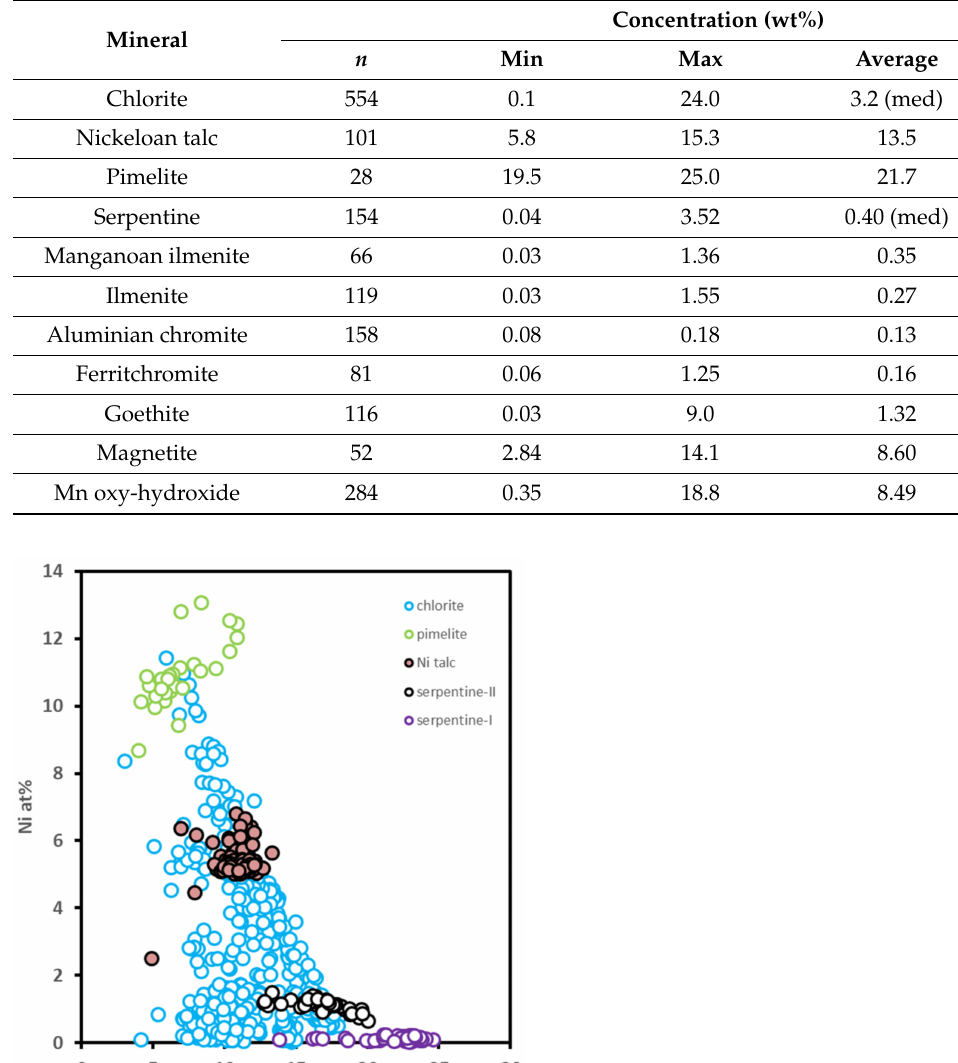
Table 7. Host minerals for Ni in the saprolitic units of the Piau í laterite profile. n = the total number of points analysed for each mineral across all samples tested. Data are from EMPA analysis.